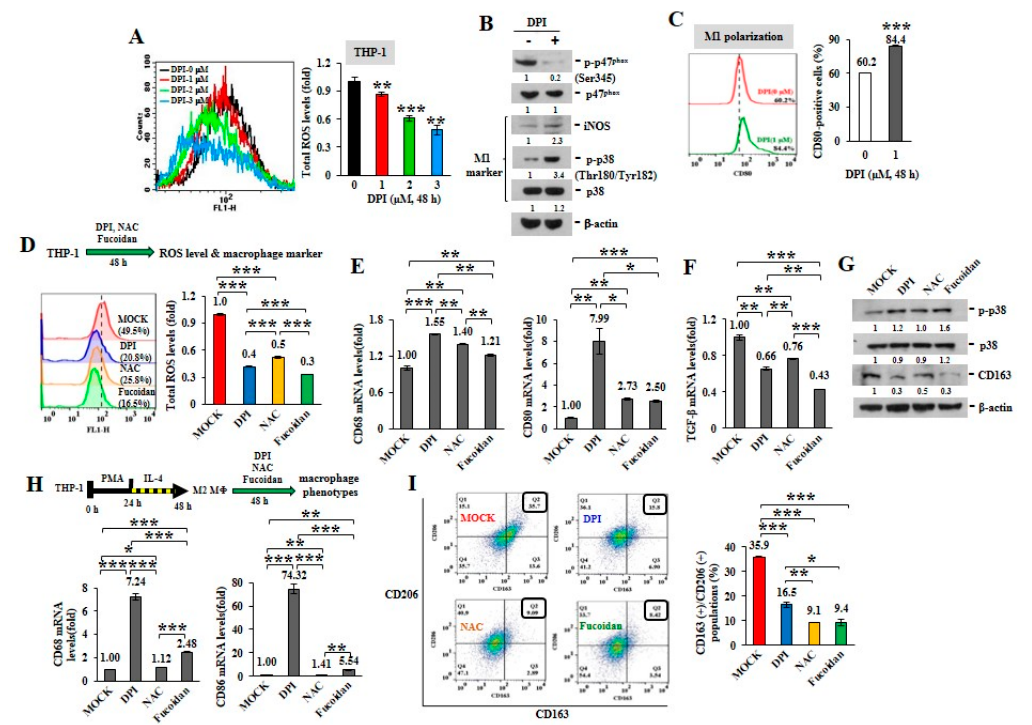
Figure 1. Reactive oxygen species (ROS) inhibitors and Oligo-Fucoidan regulate macrophage polarity. Unprimed THP-1 monocytes ( A – G ) and the M2 macrophages ( H – I ) were studied. Intracellular ROS levels were measured by 2 ′ ,7 ′ -dichlorodihydrofluorescein diacetate (DCF-DA) assay after treatment with Diphenyleneiodonium (DPI) (0–3 M) for 48 h ( A ) The amounts of nicotinamide-adenine dinucleotide phosphate (NADPH) subunit p47 phox , p-p47 phox (Ser345) and M1 marker (iNOS and p-p38 (Thr180/Tyr182)) were examined after DPI (1 M) treatment of monocytes for 48 h ( B ) The CD80(+) M1 macrophage populations were analyzed by flow cytometry ( C ) Total cellular ROS levels were assayed upon DPI (1 M), N-acetylcysteine (NAC) (1 M) and Oligo-Fucoidan (400 g/mL) treatment of monocytes for 48 h ( D ) The mRNA levels of M1 (CD68 and CD80) (E) and M2 (TGF- β ) ( F ) markers were examined by quantitative reverse transcription polymerase chain reaction ( RT-PCR) and the protein amounts of M1 (p-p38, p38) and M2 (CD163) marker were examined ( G ) M2 macrophages derived from THP-1 monocytes were stimulated with phorbol 12-myristate 13-acetate (PMA) (100 M) for 24 h and then IL-4 (20 ng/mL) for another 24 h. Upon DPI, NAC and Oligo-Fucoidan treatment of the M2 macrophages for 48 h, the mRNA levels of M1 marker (CD68 and CD86) were assayed by quantitative RT-PCR ( H ) and the CD163(+)/CD206(+) M2 macrophage populations were measured by flow cytometry (I ) Data represent the mean ± standard deviation (SD) of three independent experiments ( A,C,D,E,F,H,I ) Student’s t test determined the statistical significance of pairwise comparisons; * p < 0.05; ** p < 0.01; and *** p < 0.001. The protein level was normalized with internal control ( β -actin) and then compared with the level measured in MOCK treatment ( B,G ) The band intensity measured by ImageJ (http://rsb.info.nih.gov/ij/index.html) was indicated under each panel .